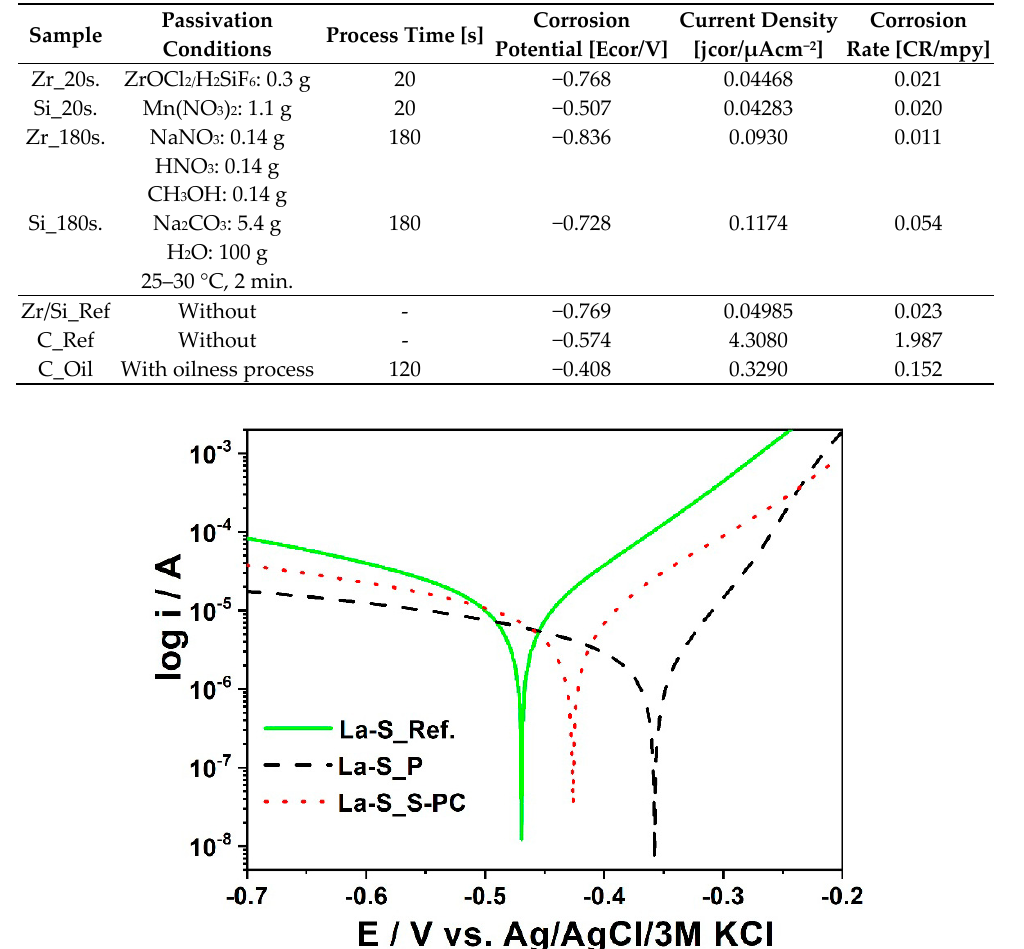
Figure 18. Polarization curves obtained of the Zr_20s, Si_20s, Zr_180s, Si_180s, Si_Ref, Zr_Ref, C_Ref, and C_Oil samples.